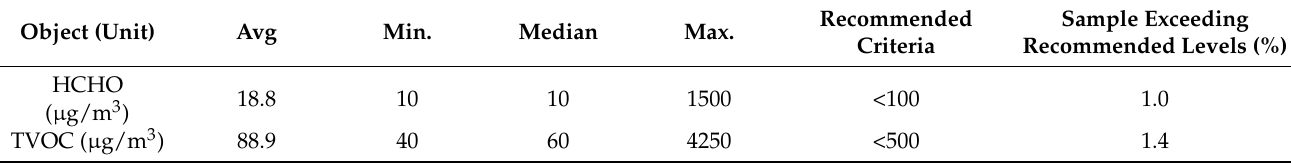
Table 3. Average concentrations of HCHO and TVOC inside the train carriage over 3 months (from November 2021 to January 2022) of T3